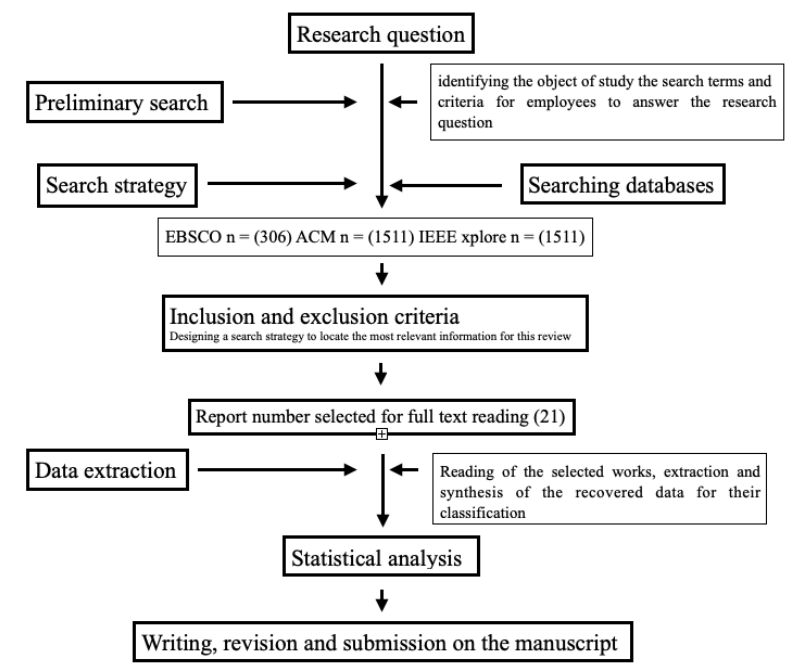
Figure 1. The flowchart shows the selection criteria made.